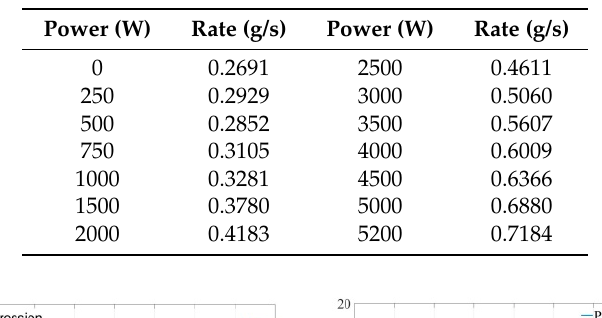
Figure 12. ( a ) Declining curve of fuel tank weight in load-free test; ( b ) Declining curve of fuel tank weight at different output power.